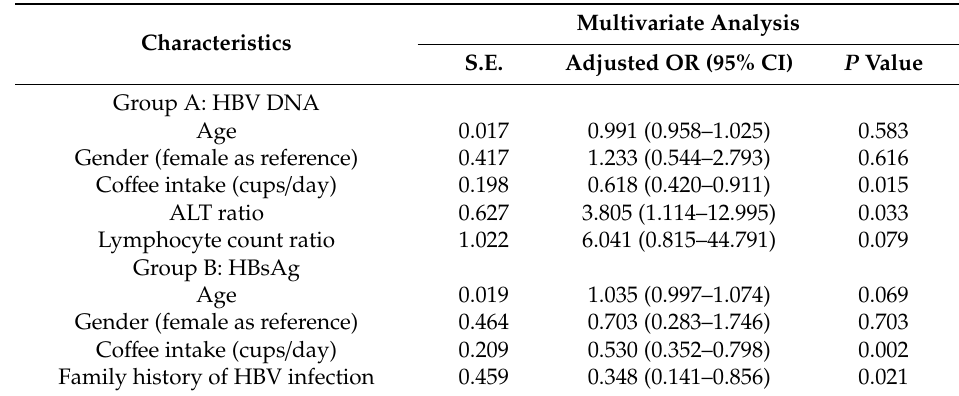
Table 3. Logistic regression modeling based on HBV DNA and HBsAg